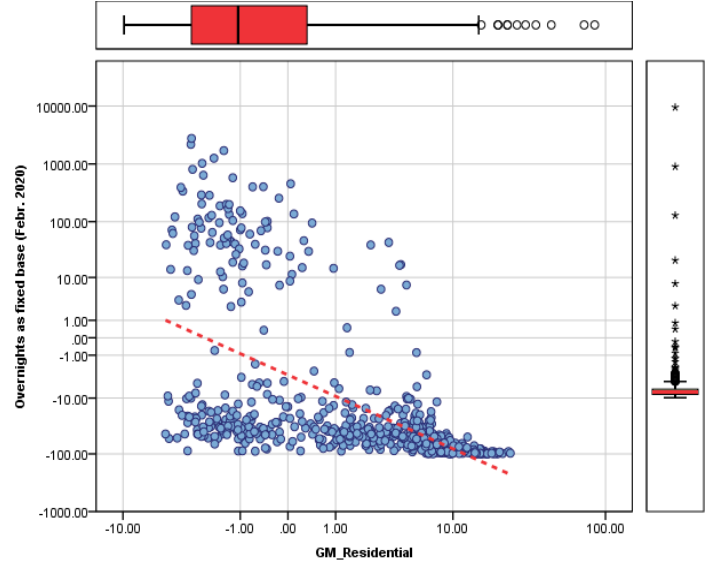
Figure 9. Overnight and GM Residential.